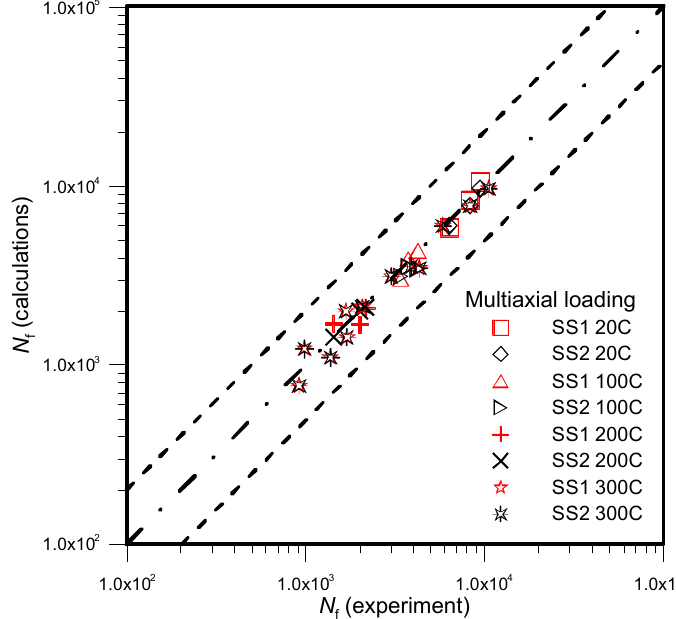
Figure 12. Comparison of the results of numerical simulations (strain-based approach) with experimental data for the EN AW-2007 aluminum alloy for complex loading histories. Table 6. Comparison of the results of numerical simulations using the SS1 model (Szusta Seweryn 2015) and SS2 model (Equation (10)) and experimental tests of the number of cycles N f for different loading paths (EN AW-2024 T3).